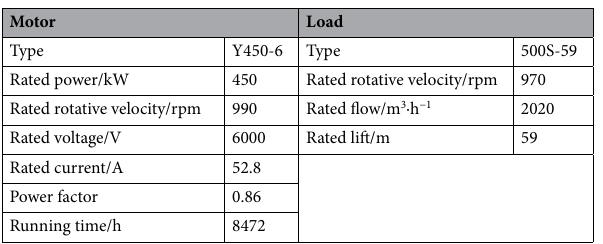
Table 2. Basic parameters of the motor and load.